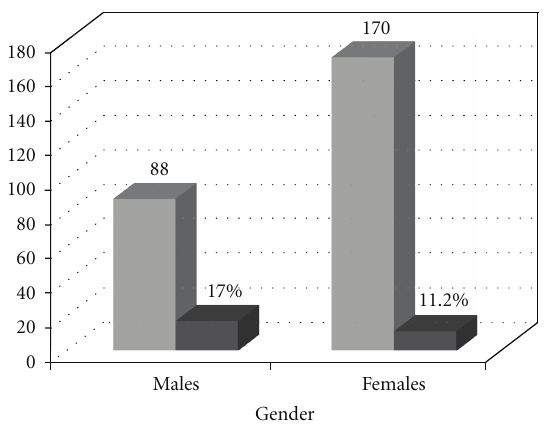
Figure 4: Seroprevalence of Chagas disease distributed by genders compared with the total of sera. Total samples analysed 258 (88 males and 170 females).